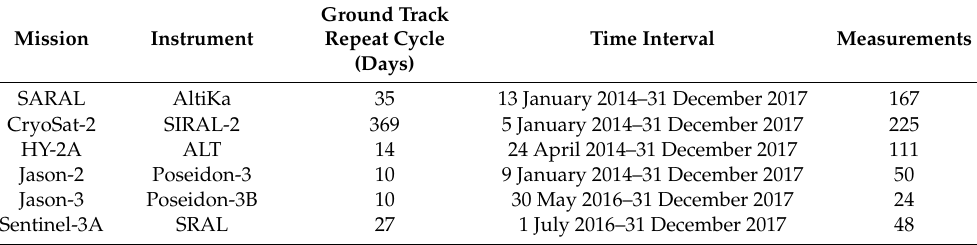
Table 3. Overview of the satellite altimetry missions used